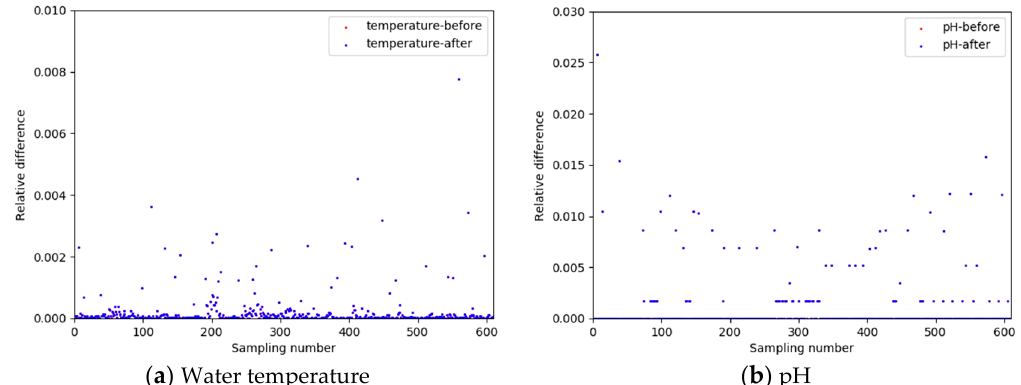
Figure 10. Comparison of relative differences before and after data correction.